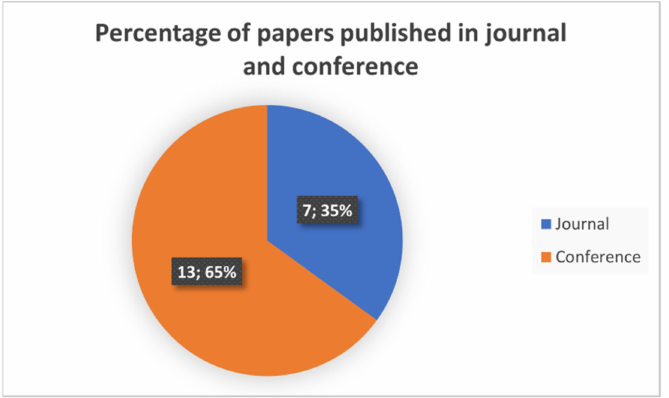
Figure 4. Percentage of papers published in journals and conferences that fulfill the quality criteria